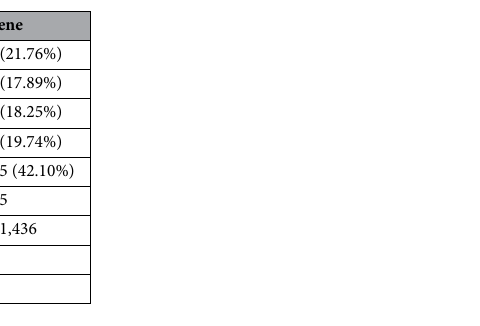
Table 2. Number and length of transcripts and unigenes.